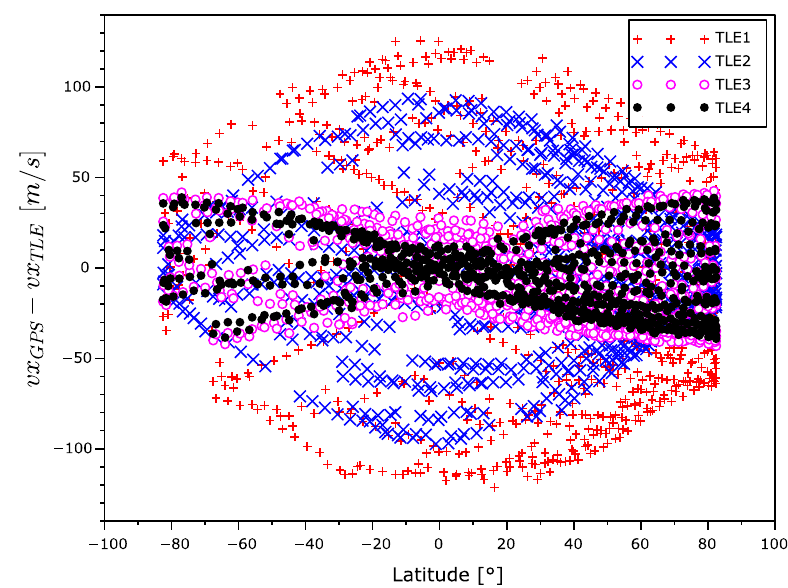
Figure 15. x coordinate velocity error as a function of latitude.